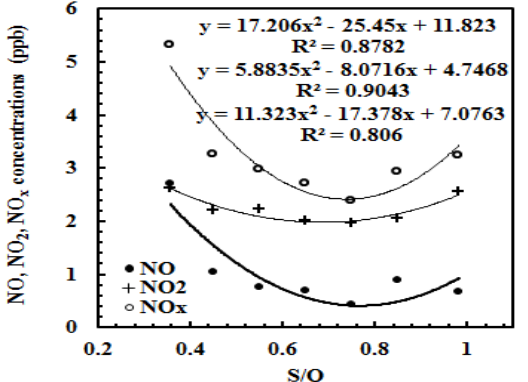
Figure 8. The relationships between NO, NO 2 , NOx and S/Q; the regression parameters obtained from a polynomial fit are for NO, NO 2 and NOx from top to bottom, respectively.